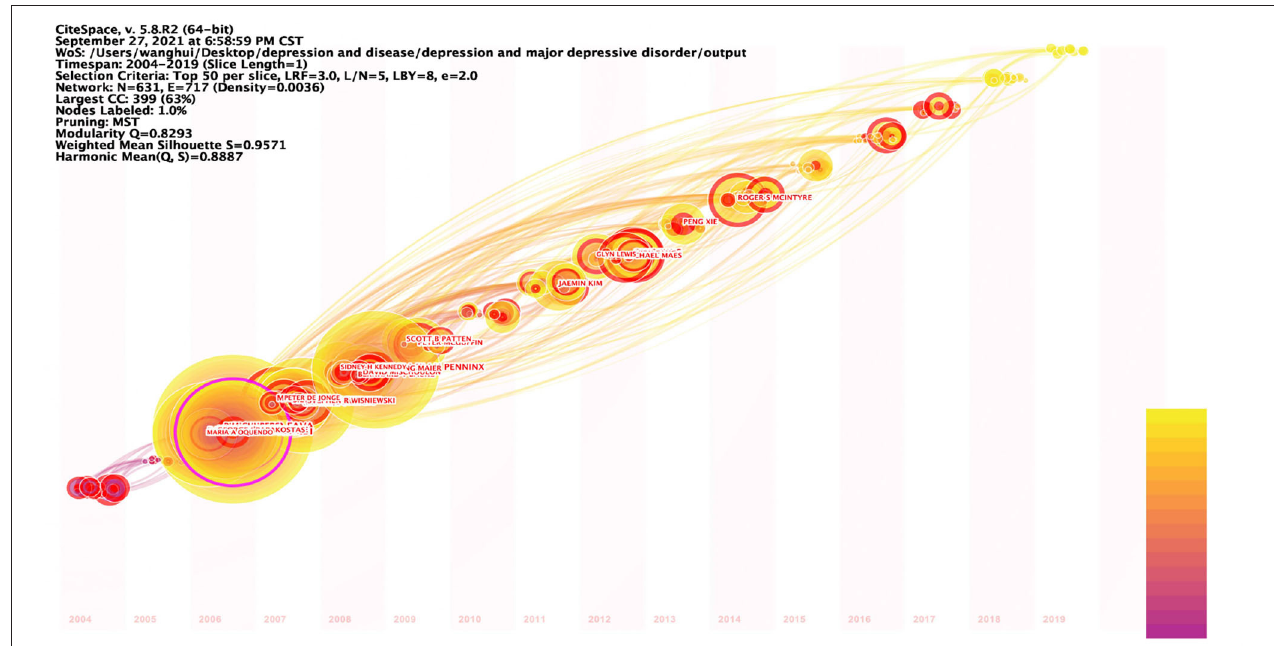
FIGURE 5 | Timezone view of the author’s co-existing network in depression, 2004–2019. The circle represents the author, the time zone in which the circle appears is the year in which the author first published in this study dataset, the radius of the circle represents the frequency of appearance, the color represents the different posting times, the lines represent the connections between authors, and the time zone diagram shows the evolution of author